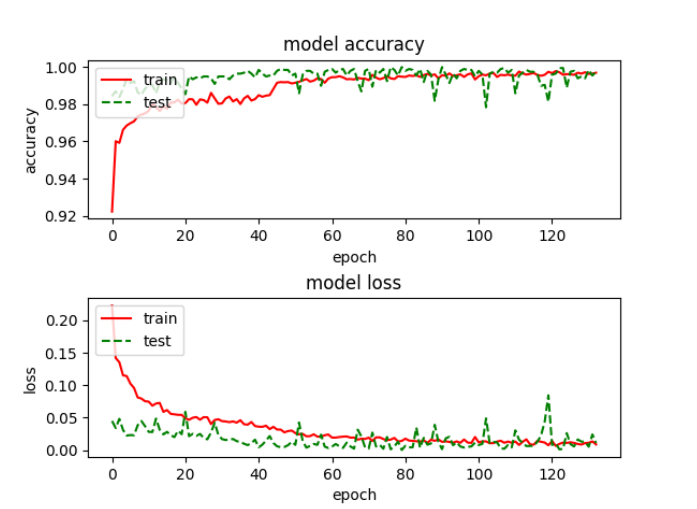
Figure 11. Accuracy and loss graphs of the CNN-based model which is trained without the early stopping technique [48].